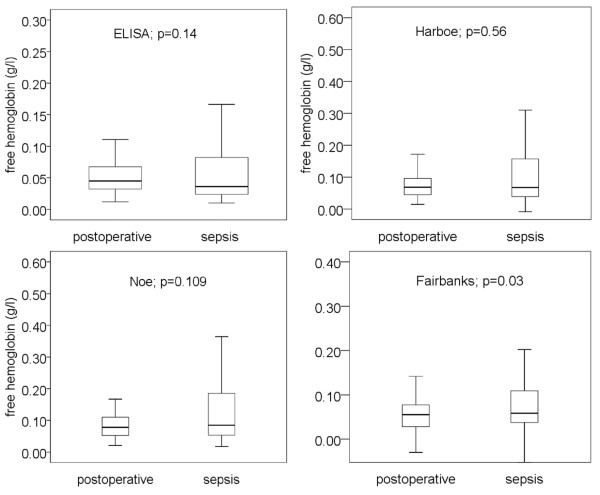
Free hemoglobin measured in postoperative patients and patients with severe sepsis using four methods. Free hemoglobin did not differ in postoperative and septic patients using three of the four methods. Therefore, free hemoglobin cannot serve as a biomarker for the diagnosis of severe sepsis in critical illness. Data are given in boxplots (median, quartile, minimum, maximum). For statistical evaluation the Mann-Whitney test was used. Methods used to measure free hemoglobin were ELISA and the spectrophotometric methods of Harboe [13], Noe [14] and Fairbanks [15].